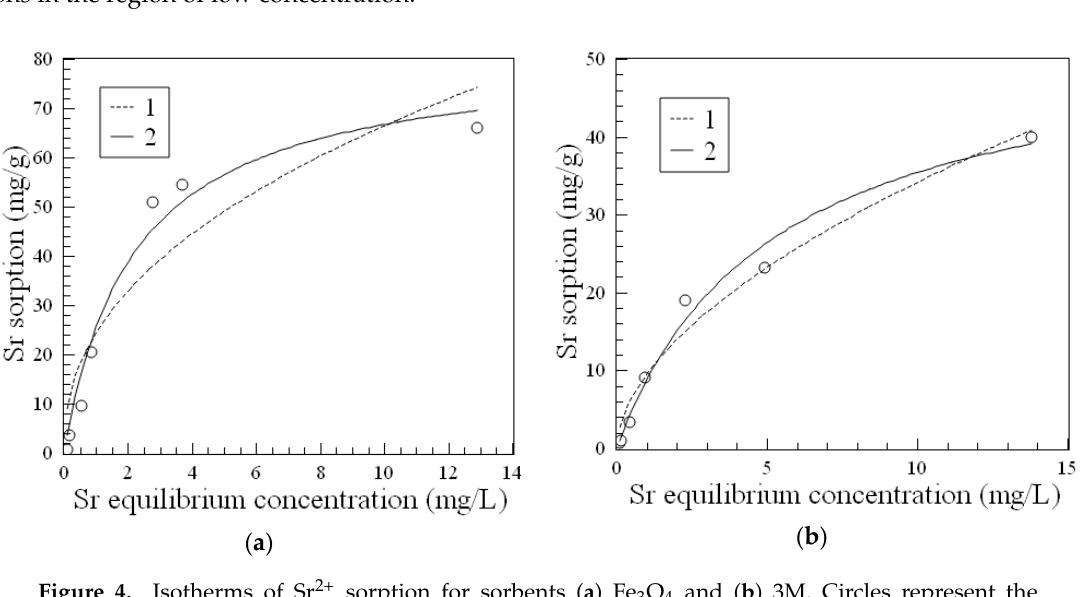
Figure 4. Isotherms of Sr 2+ sorption for sorbents ( a ) Fe 3 O 4 and ( b ) 3M. Circles represent the experimental data; fit lines are computed using the Freundlich and Langmuir equations (Equations (1) and (2), respectively).